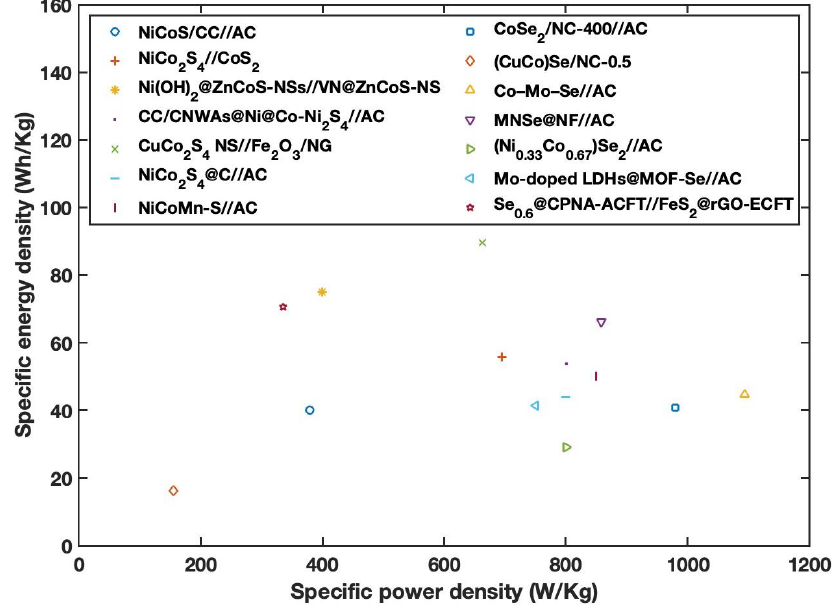
Figure 8. Ragone plot for the supercapacitors [14,15,17,18,20,22,24,31 –